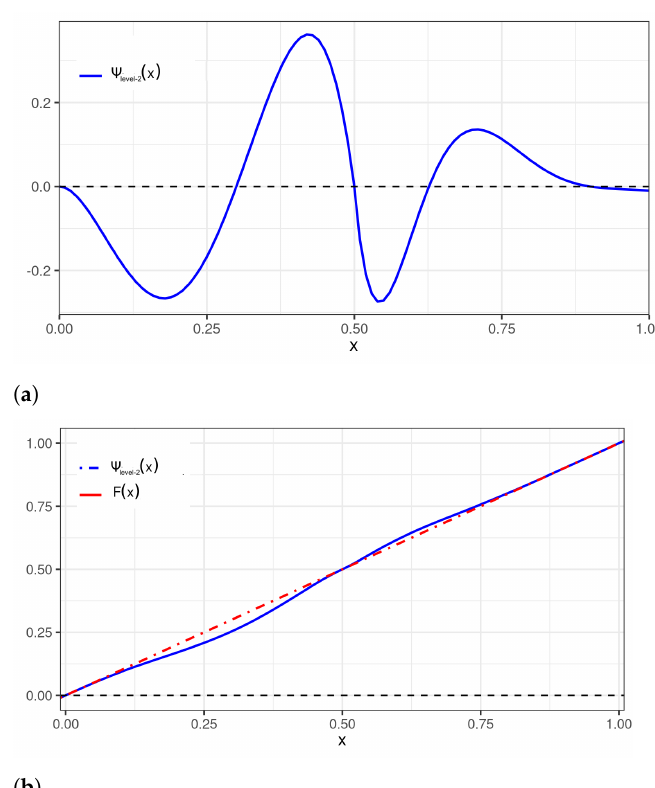
Figure 6. Plots of: ( a ) a level-2 beta wavelet perturbation to be applied to the U [ 0,1 ] distribution; and ( b ) level-2 beta wavelet perturbation (— blue) and uniform (- · - red)